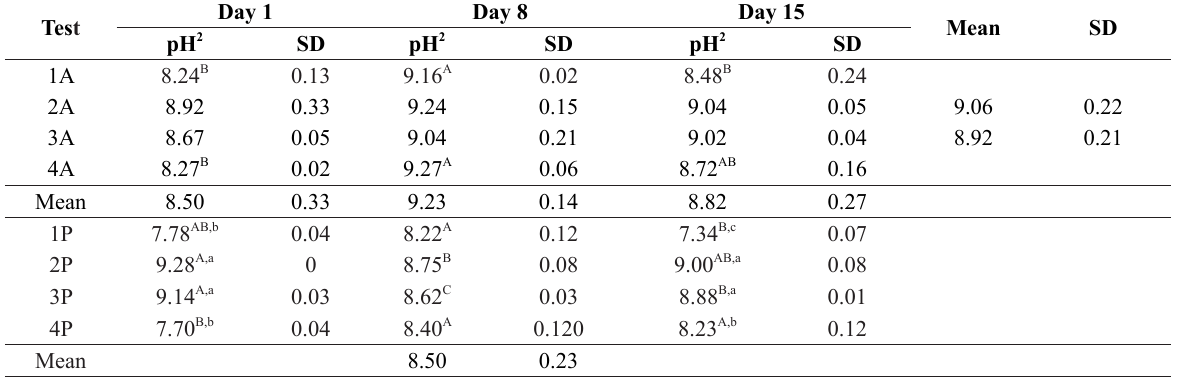
pH 1 values for the tests of biological treatment of textile waste under more (A) and less (P) intense agitation, with leachate, and adding molasses (1), vinasse in lower (2) and higher (3) concentrations, and 50/50 molasses/vinasse (4). (See Table I).